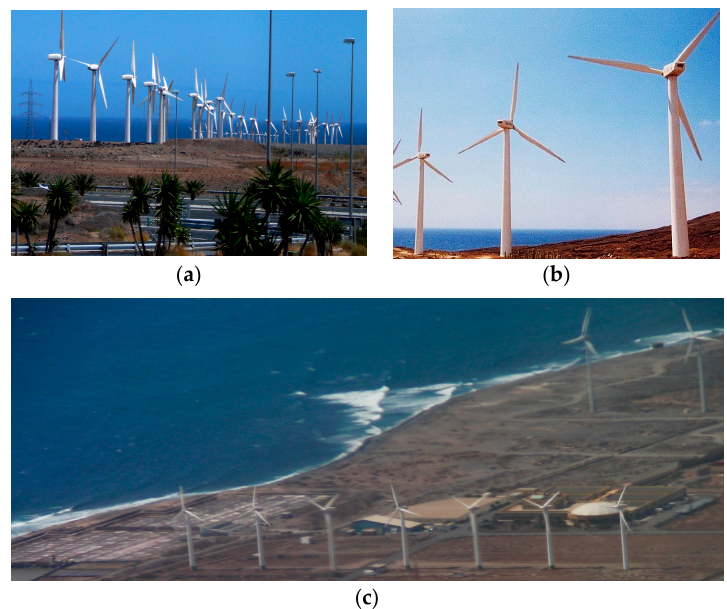
Figure 1. Examples of wind farms in isolated locations: ( a ) Gran Canaria, ( b ) Tenerife, and ( c ) Terceira. Photo: G. Jastrz ę bska.